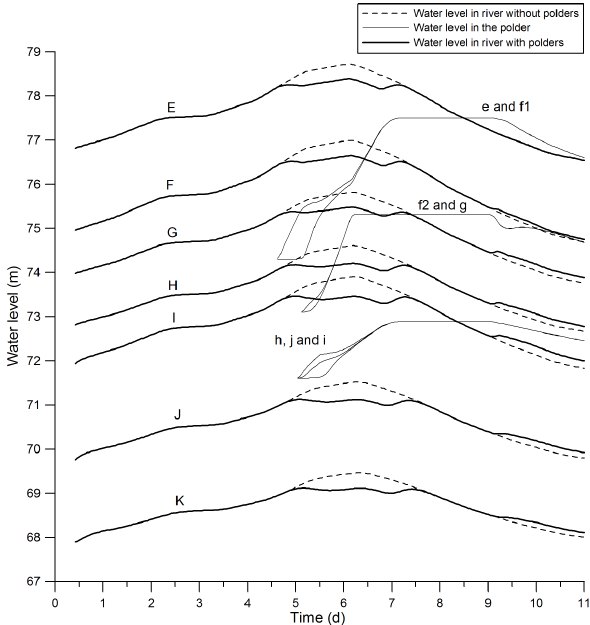
Fig. 13. Water levels in the river and P4 when only P4 is used for flood water diversion. See Fig. 3 for river locations E to K.